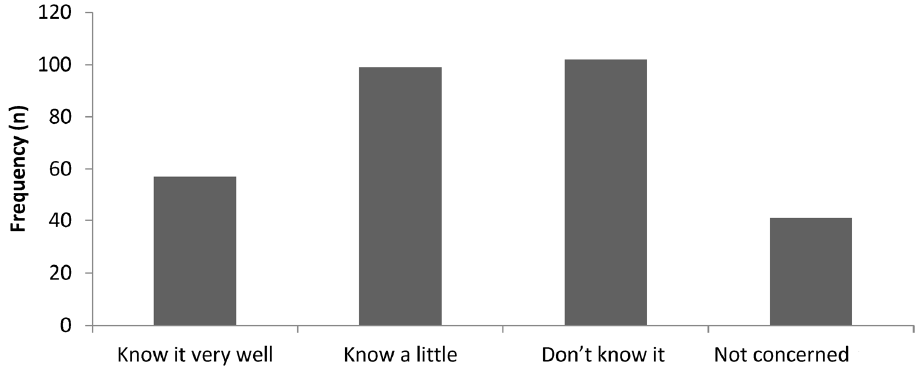
Figure 3. Level of rooibos farmers’ knowledge of quality assurance (QA) systems.